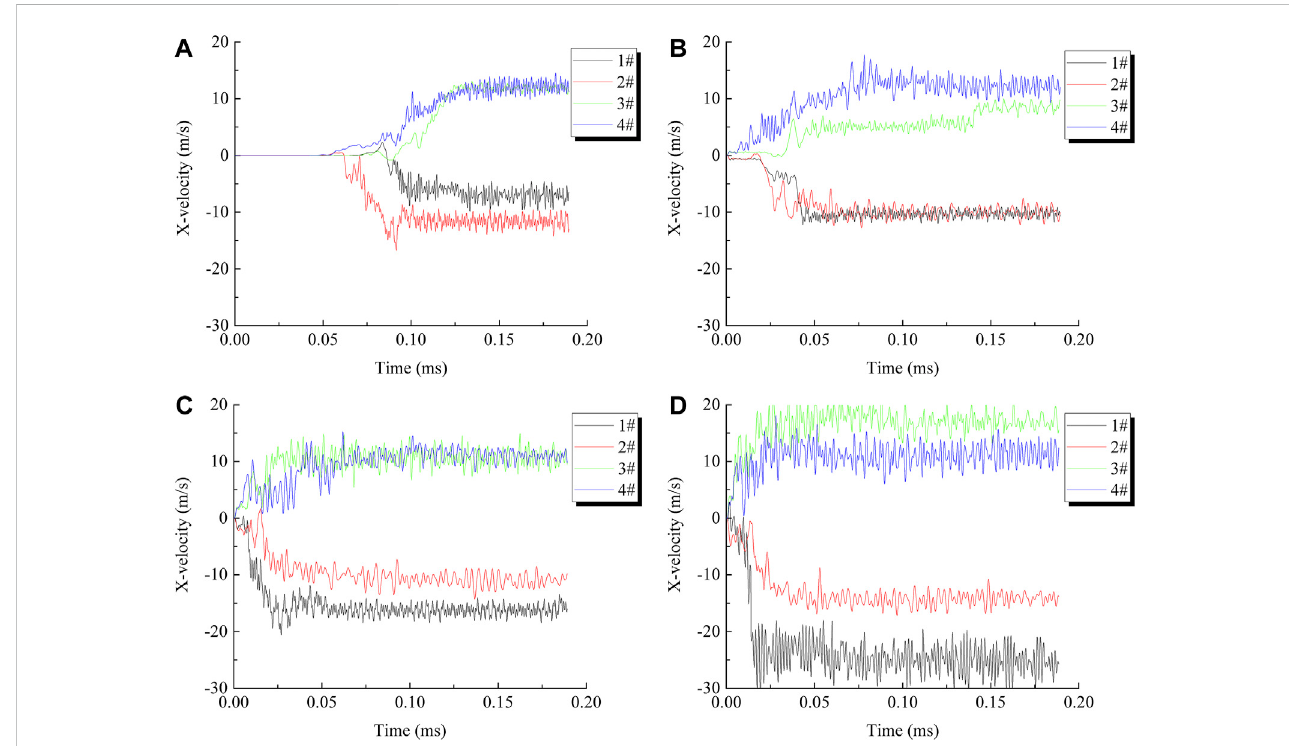
FIGURE 6 Magnitudes of horizontal velocities of fragments under different pre-con fi ning pressures: (A) .1 MPa; (B) 1.0 MPa; (C) 2.5 MPa and (D) 5.0 MPa.